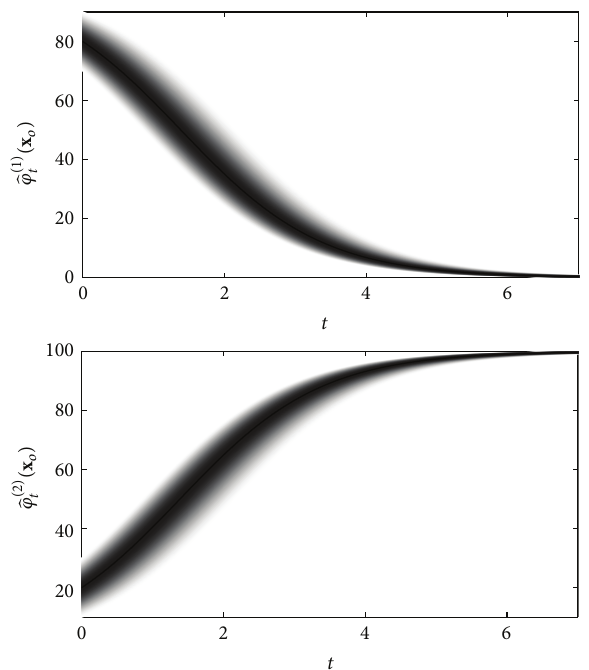
Figure 5: Time evolution of the fuzzy projection ̂𝜑 𝑡 ( x 𝑜 ) on the axes 𝑆 and 𝐼